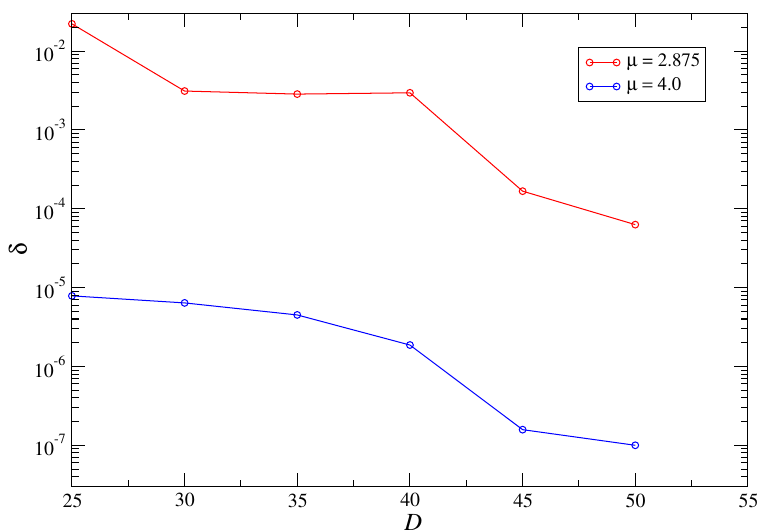
Figure 5 . Convergence behavior of thermodynamic potential as a function of D on V = 1024 4 with m = 0 . 01